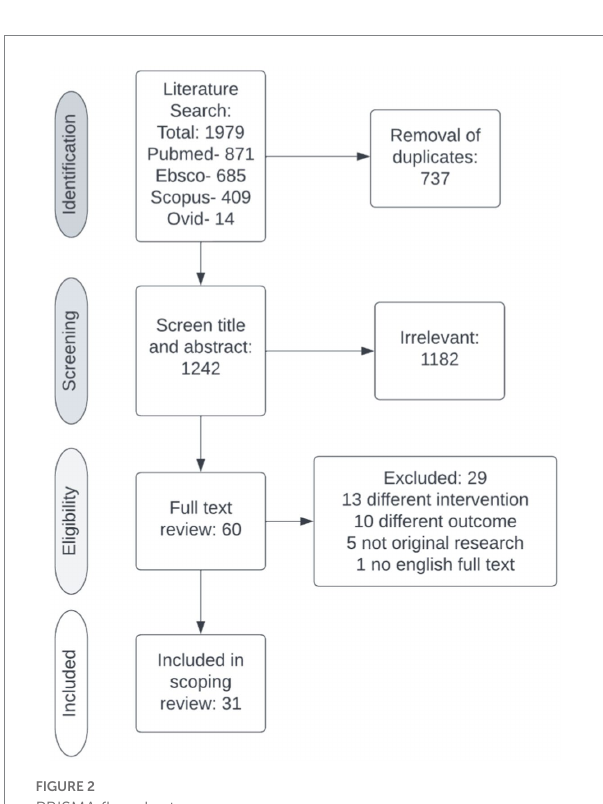
FIGURE 2 PRISMA